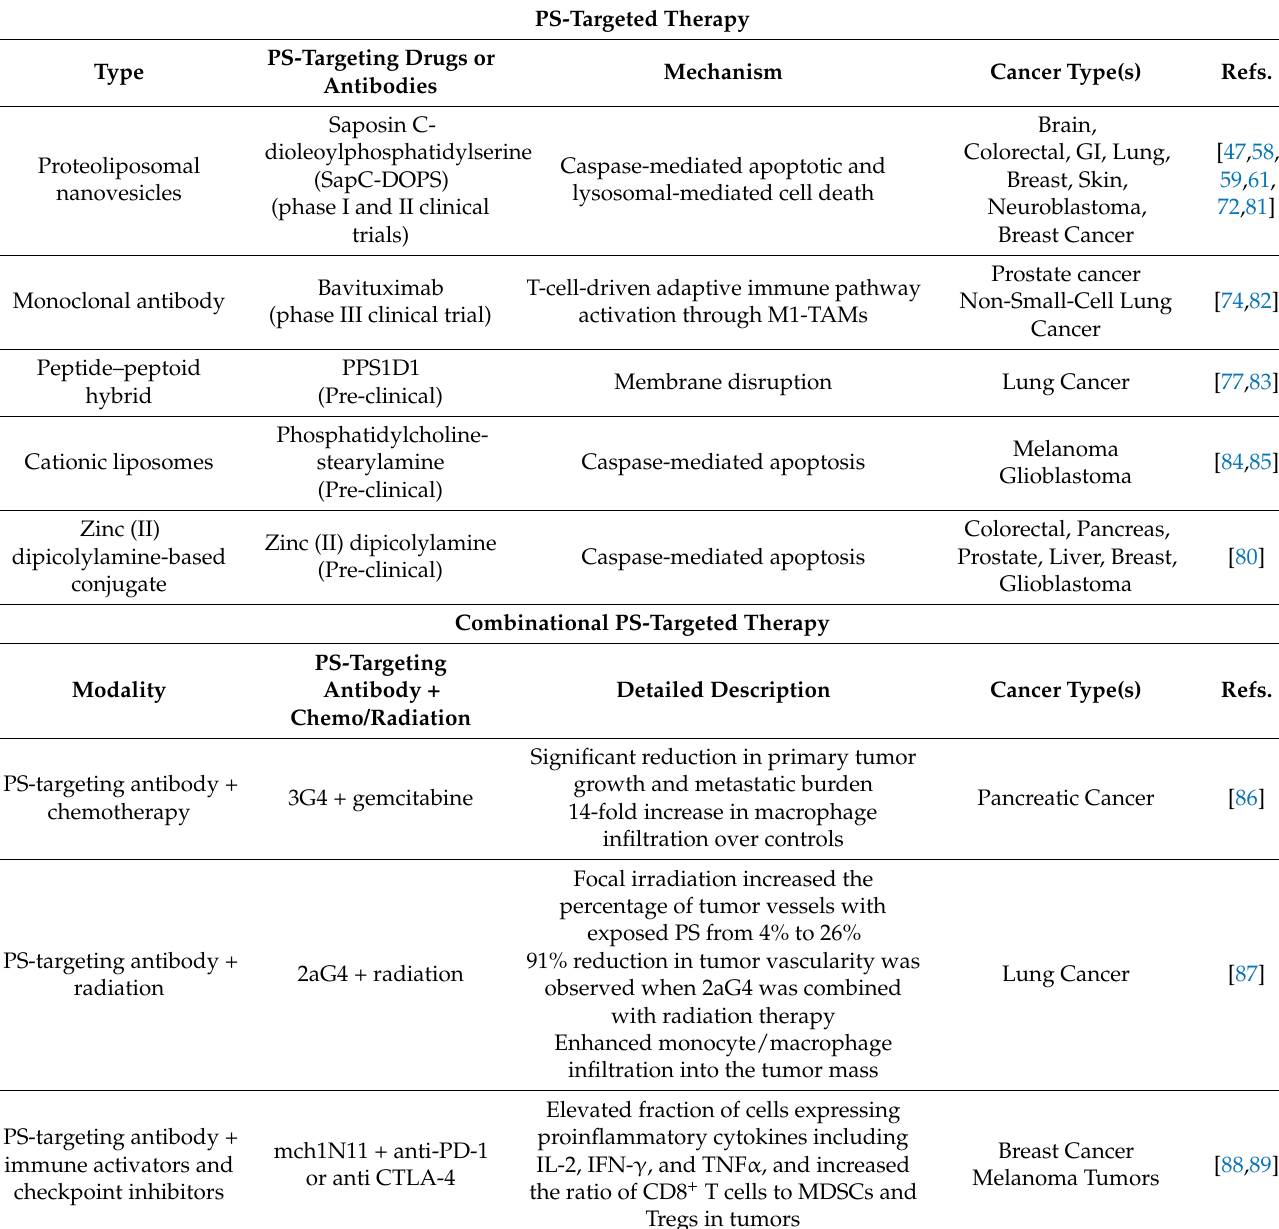
Table 2. Phosphatidylserine (PS)-targeted therapy